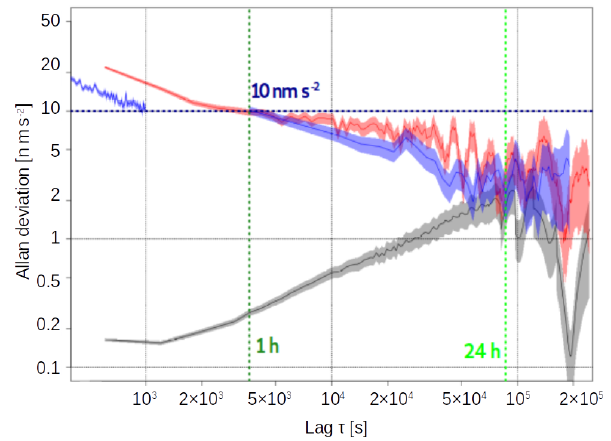
Figure 4. Comparison of sensitivity with (orange) and without (grey) placing the AQG-B01 tripod on rubber pads. The measure- ment without rubber pads were conducted on 23–26 April 2020 and those without pads on 28 April